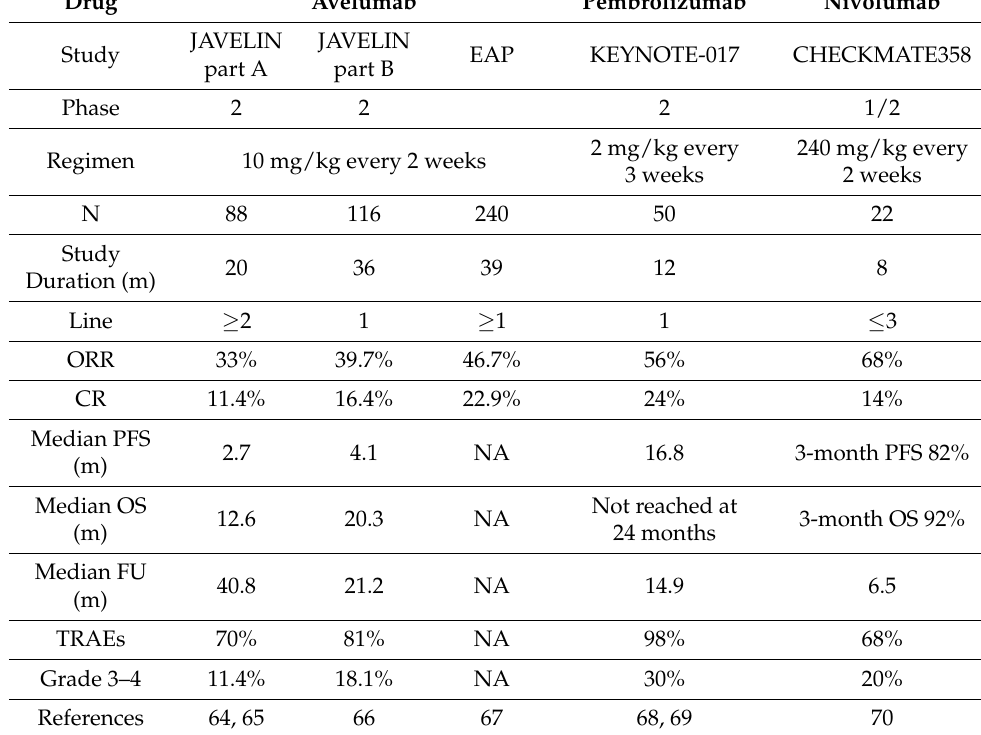
Table 1. Efficacy results from clinical trials evaluating anti-PD-1/PD-L1 inhibitors for the treat- ment of locally advanced and metastatic MCC. N: number of included patients, EAP: expanded access program, ORR: overall response rate, CR: complete response, PFS: progression-free sur- vival, OS: overall survival, FU: Follow-up, TRAE: treatment-related adverse events, m: months, NA: not